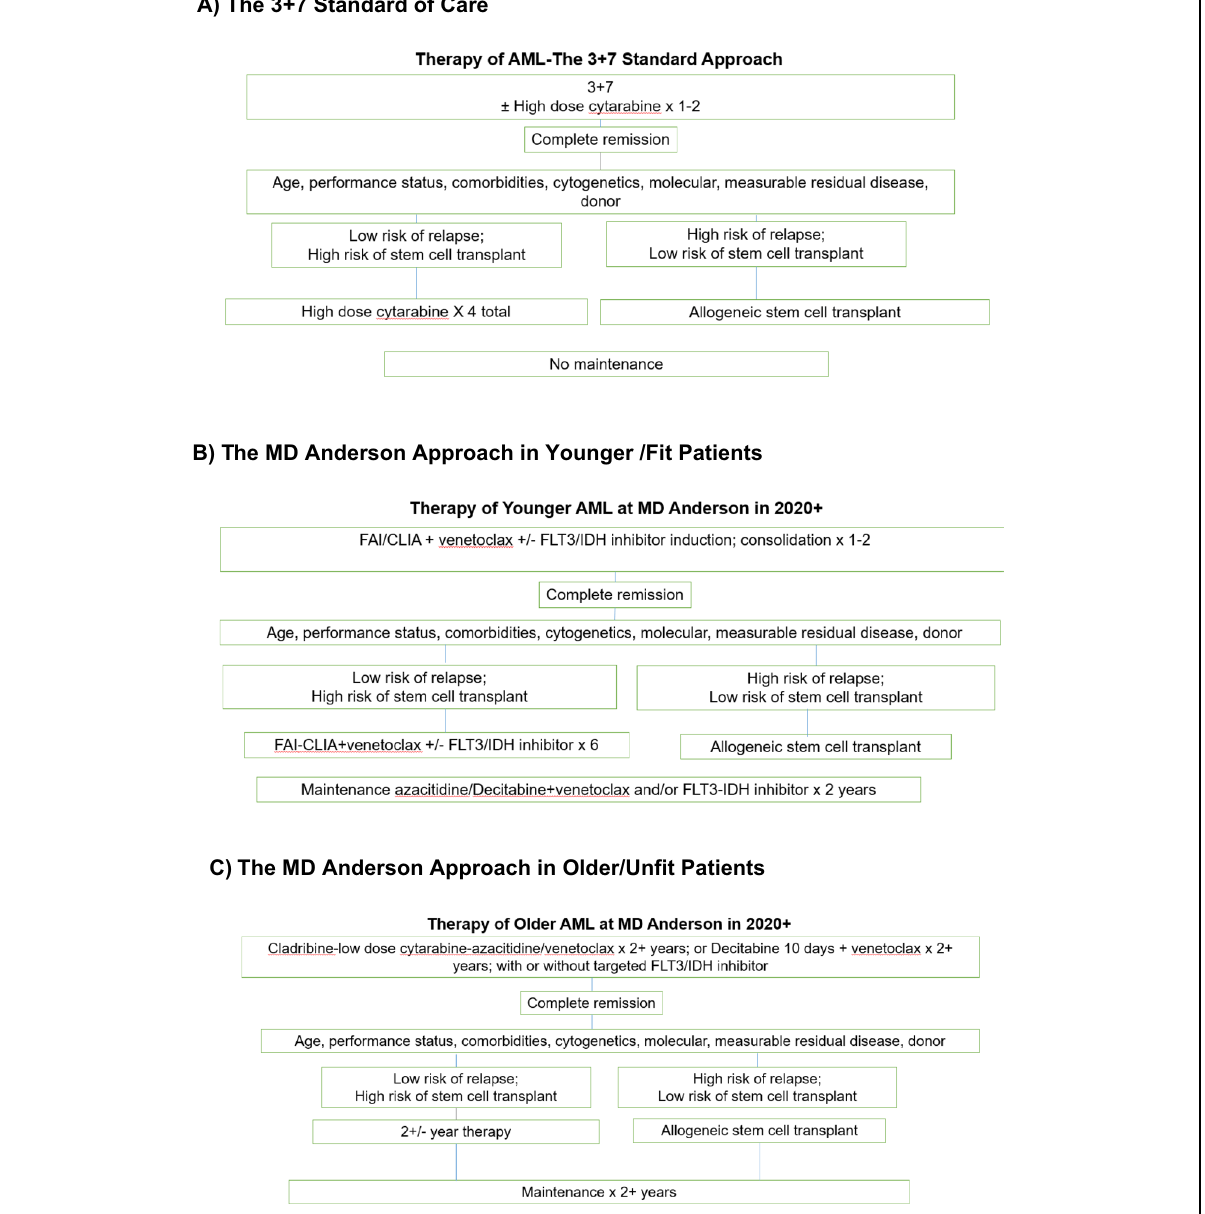
Fig. 4 Therapy of AML. A standard of care; B MD Anderson approach in young/ fi t patients, and C in older